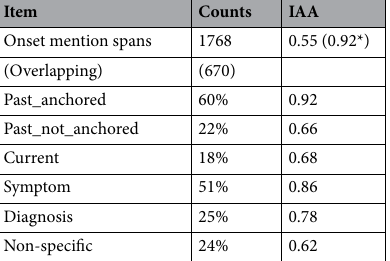
Table 6. Dataset annotation. Number of onset mentions in the whole annotated dataset (total number and overlapping set), and attribute frequency in the adjudicated dataset (Time_information and Type). IAA inter- annotator agreement. *Indicates agreement between the adjudicator and the union of annotations.